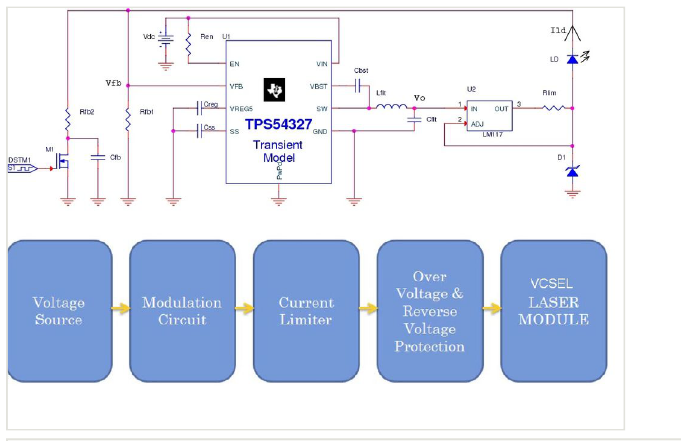
The circuit that allows for triangular wave modulation of the VCSEL drive current. The corresponding block diagram of the circuit scheme that drives the VCSEL is given below the drive